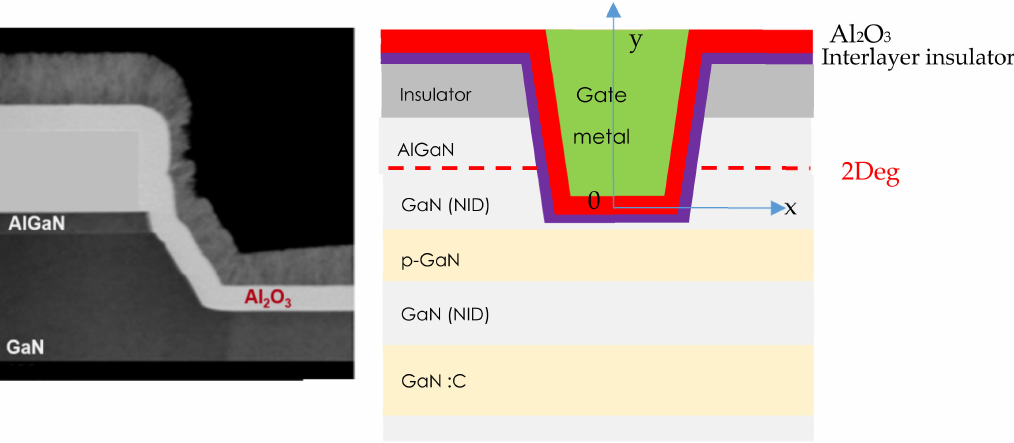
Figure 2. Detailed cross-section of metal insulated semiconductor gate (MISGate). TEM image and layers stack